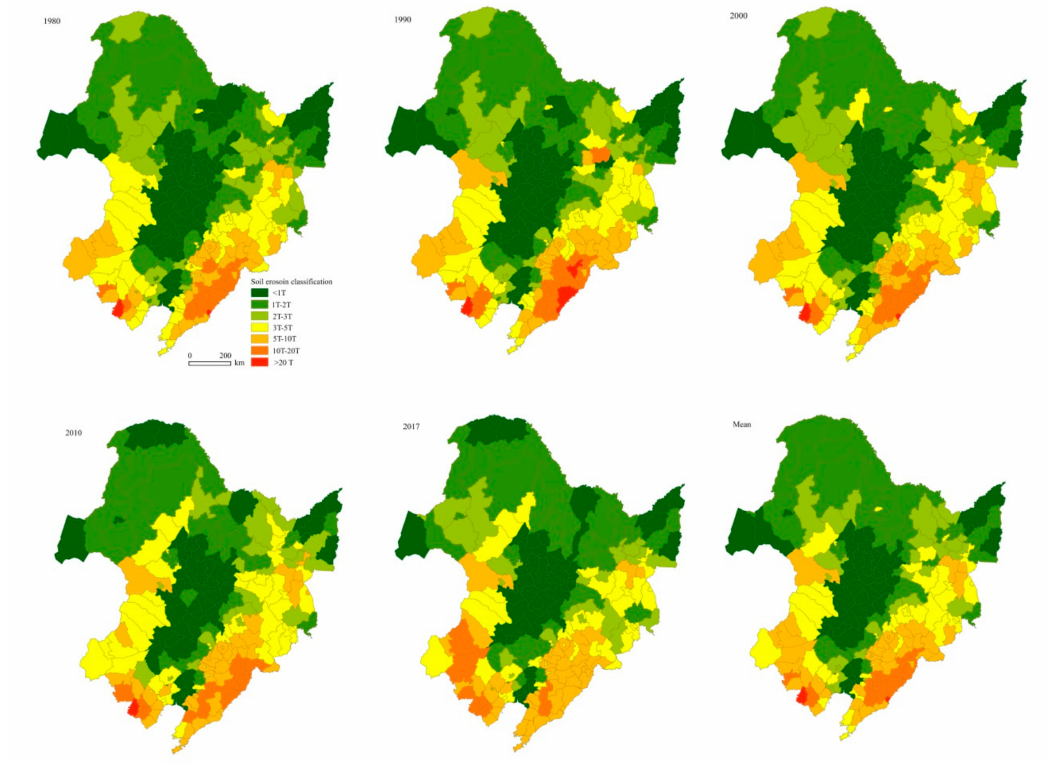
Figure 8. Maps showing the mean rate of soil erosion in 1980, 1990, 2000, 2010, 2017, and the average during the study period at a county scale in